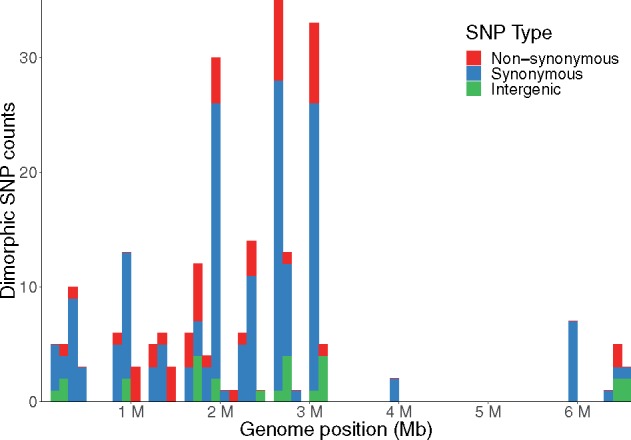
—Dimorphic SNV loci in Pseudomonas aeruginosa. Dimorphic SNV loci are defined as core genome positions with one variant in at least 98% of the Group A isolates and a different variant present in at least 98% of the Group B isolates. Each bar represents the total number of dimorphic SNV loci within a 100-kb window relative to the PA14 genome. Numbers of SNVs within coding regions predicted to encode a different amino acid (nonsynonymous mutations) are shown in red, whereas those SNVs not predicted to result in an amino acid change (synonymous mutations) are shown in blue. Numbers of SNVs found within intergenic regions are shown in green.